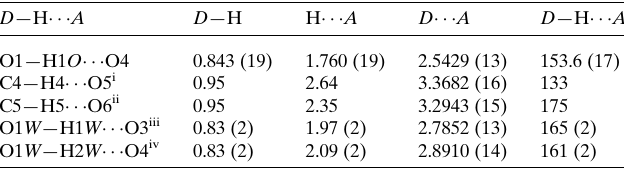
Table 1 Hydrogen-bond geometry (A˚ , (cid:5) ) for I .